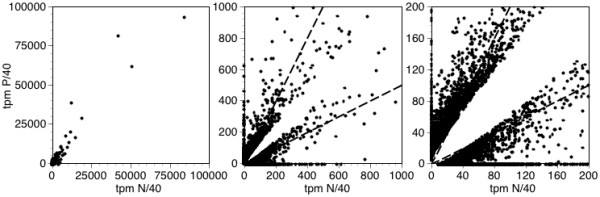
Paired abundance data for all signatures with differential expression significant at p < 0.05. Each data point corresponds to a signature with expression that is significantly different between the N/40 and P/40 libraries at p < 0.05. Data are plotted as signature expression in the P/40 library (x-axis) vs. expression in the N/40 library (y-axis). The axis scale decreases from left to right panels to show detail. Dashed line is the line of constant expression, i.e. the point at which the expression ratio is two-fold different between the two conditions.